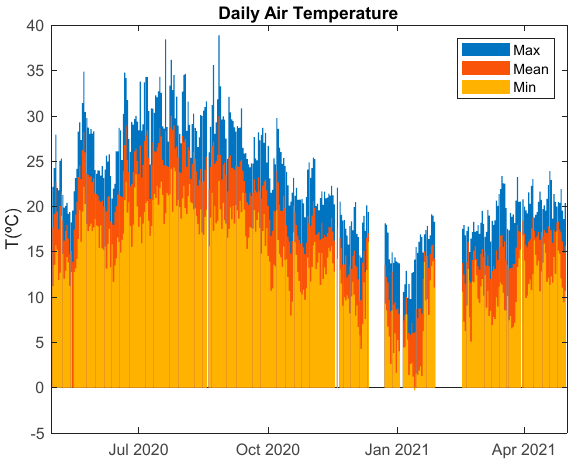
Figure 4. Maximum, mean, and minimum annual air temperature.